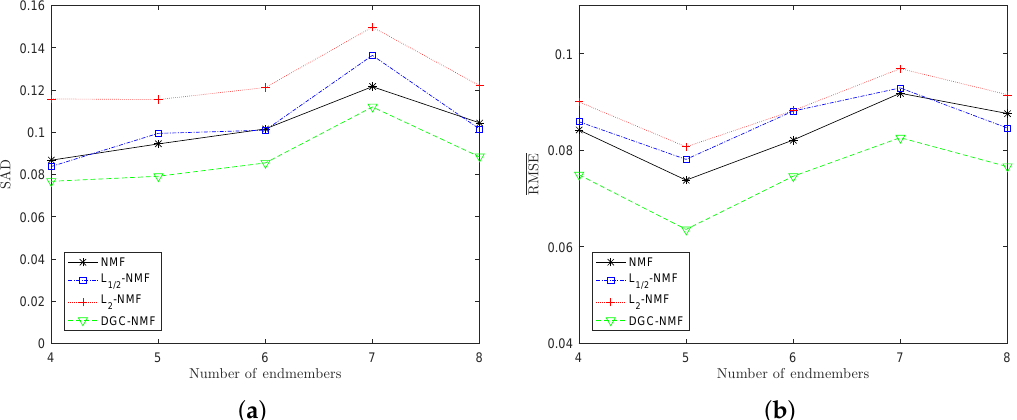
Figure 9. Performance comparison of the algorithms when the number of endmembers varies. ( a ) SAD; ( b ) RMSE.